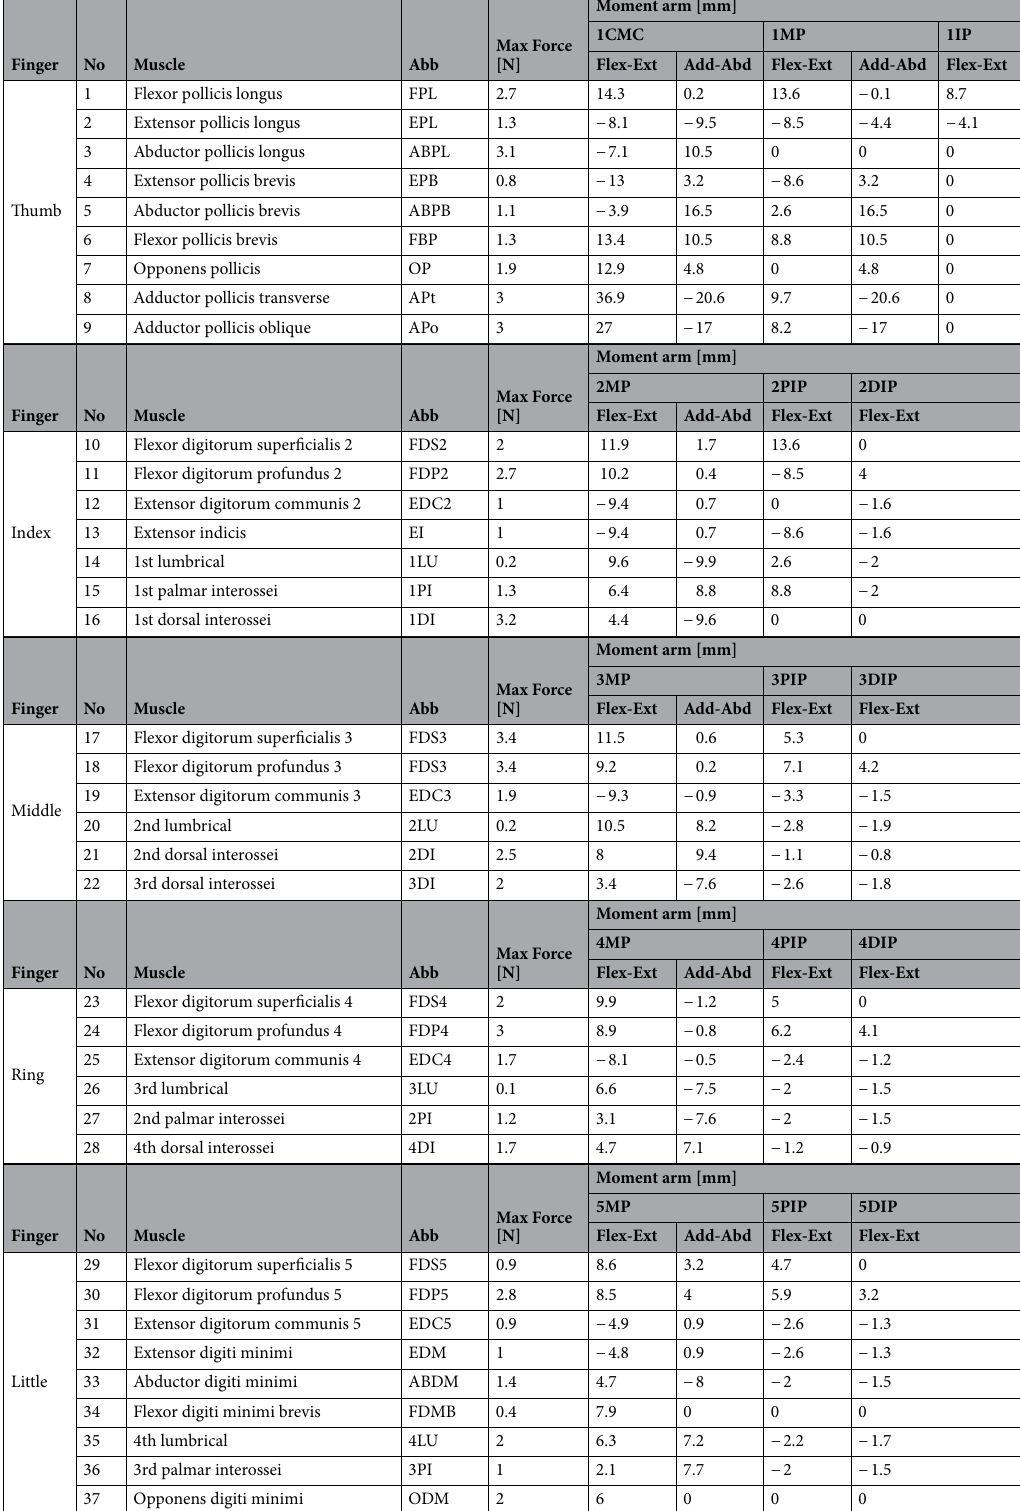
Table 1. Muscle parameters of the hand musculoskeletal model. Abb = abbreviation. CMC = Carpometacarpal joint, MP = Metacarpophalangeal joint, IP = Interphalangeal joint, PIP = Proximal IP joint, DIP = Distal IP